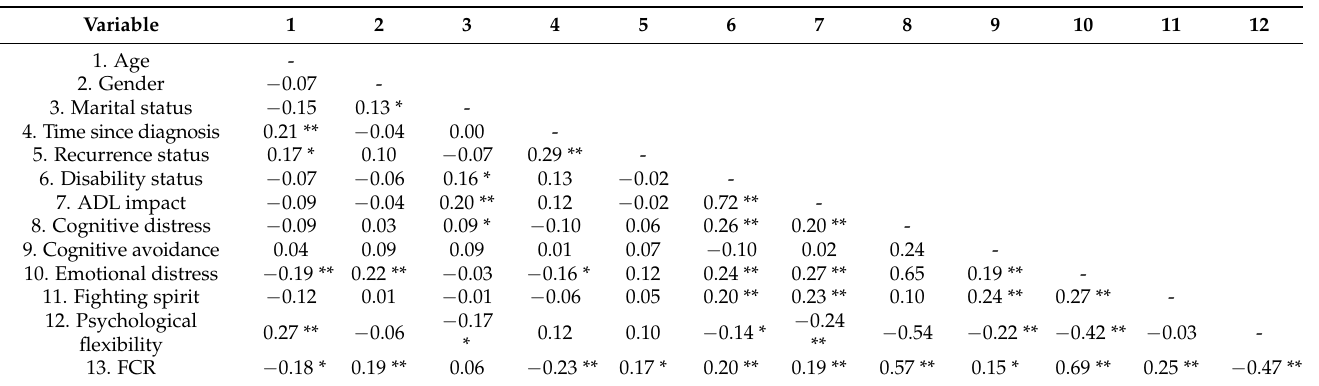
Table 2. Bivariate correlations of study variables.